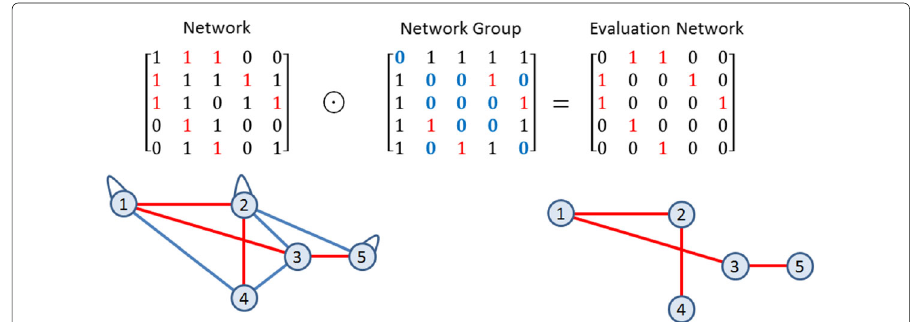
Fig. 5 A network (left) projected for evaluation (right) to a network group (middle) that removes the evaluation of the blue edges. Rows and columns of the adjacency matrices correspond to the respective node